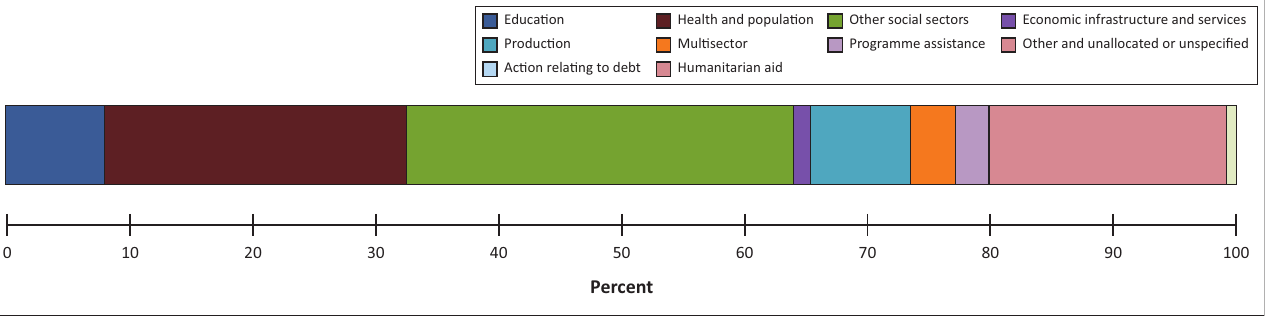
FIGURE 2 : Resource flow to Zimbabwe